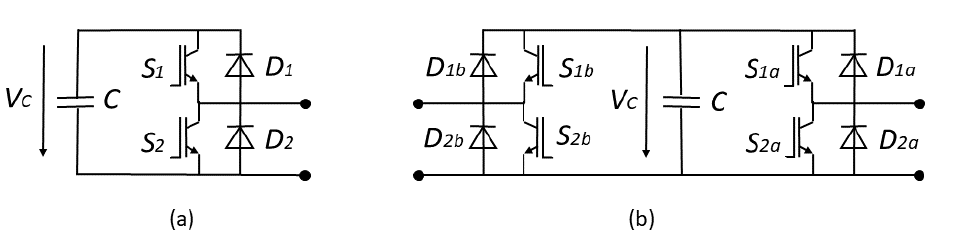
Figure 4. MMC submodules. ( a ) Half bridge submodule. ( b ) Full bridge